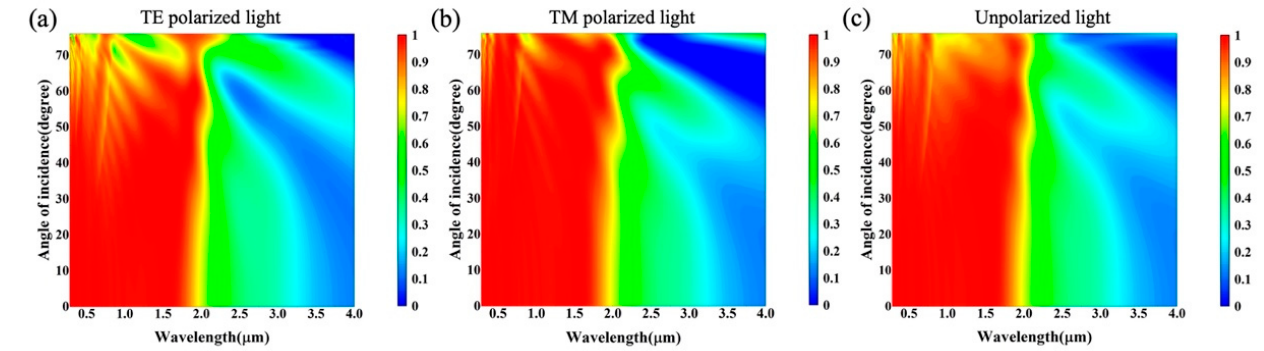
Figure 10. Absorptance spectra of absorbers with different incident angles. ( a ) TM ‐ polarized wave. ( b ) TE ‐ polarized wave. ( c ) Unpolarized light. The incident angle step is 2° from 0° to 76°.